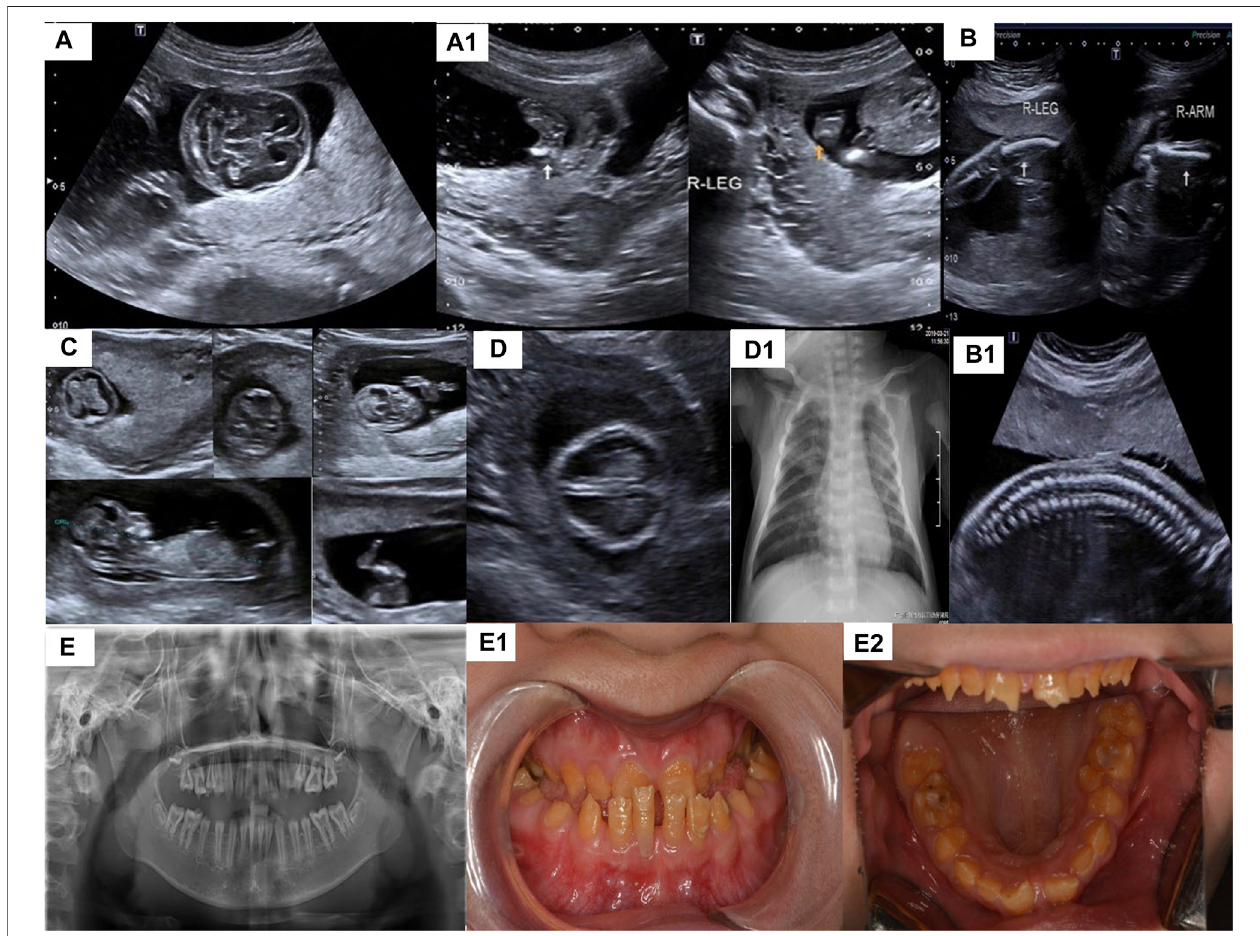
FIGURE 1 | (A,A1) are the imaging examination results of the patient 1 ( (A) : the echo intensity of the skull is obviously weaker than the midline of the brain, (A1) : Micromelia, leg posture is fi xed and twisted), (B,B1) are the imaging examination results of patient 2 [ (B) : short and curved femur and humerus, (B1) : spine had “ beaded changes ” ] (C) is the imaging examination results of patient 3 (tetraphocomelia, abnormal posturing, decreased calvarial and long bones ossi fi cation, thin ribs), (D) is the imaging examination results of patient 4, [ (D) : Decreased skull echogenicity. (D1) : pneumonia,bell-shaped thorax and some of the ribs are rachitic rosary], (E – E2) are the teeth imaging examination results and the appearance of patient